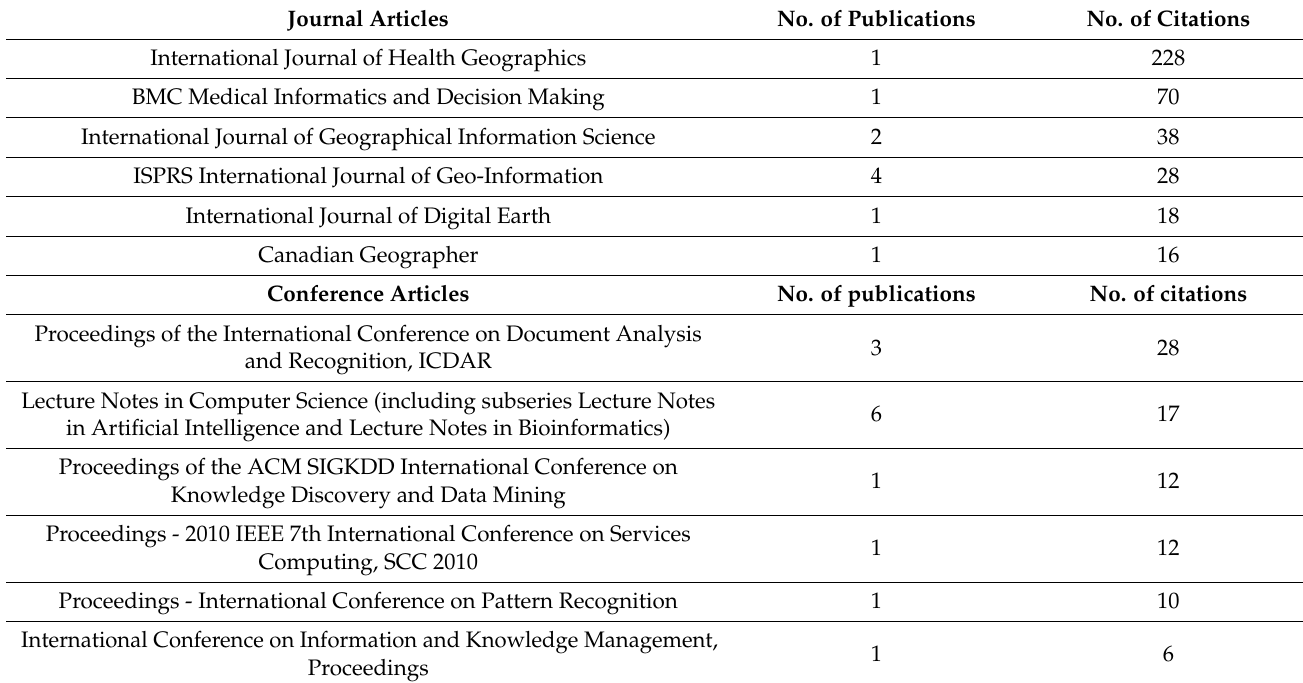
Table 3. Main sources by number of